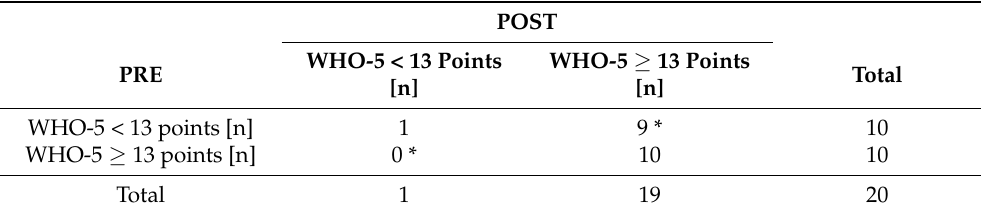
Table 2. Cross-tabulated WHO-5 subjective well-being rating scale data before (PRE) and after (POST) the intervention.